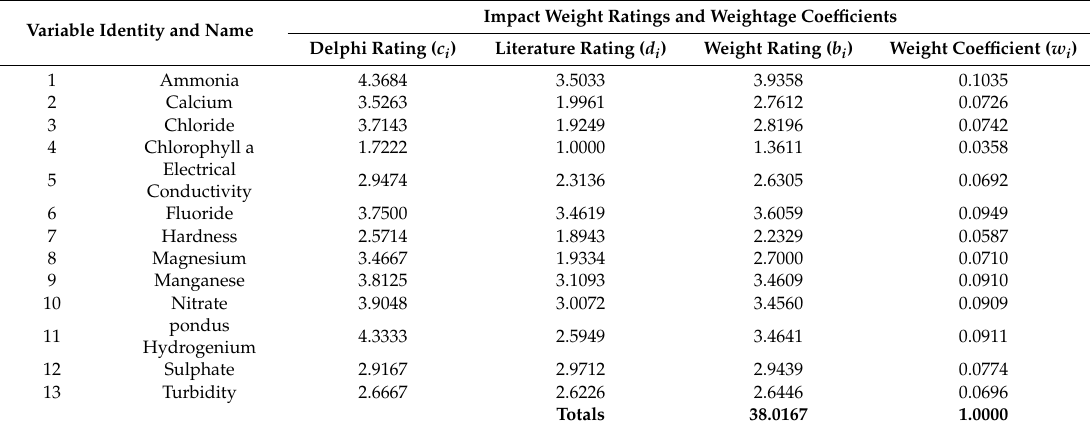
Table 3. Parameters of consideration and their weight coe ffi